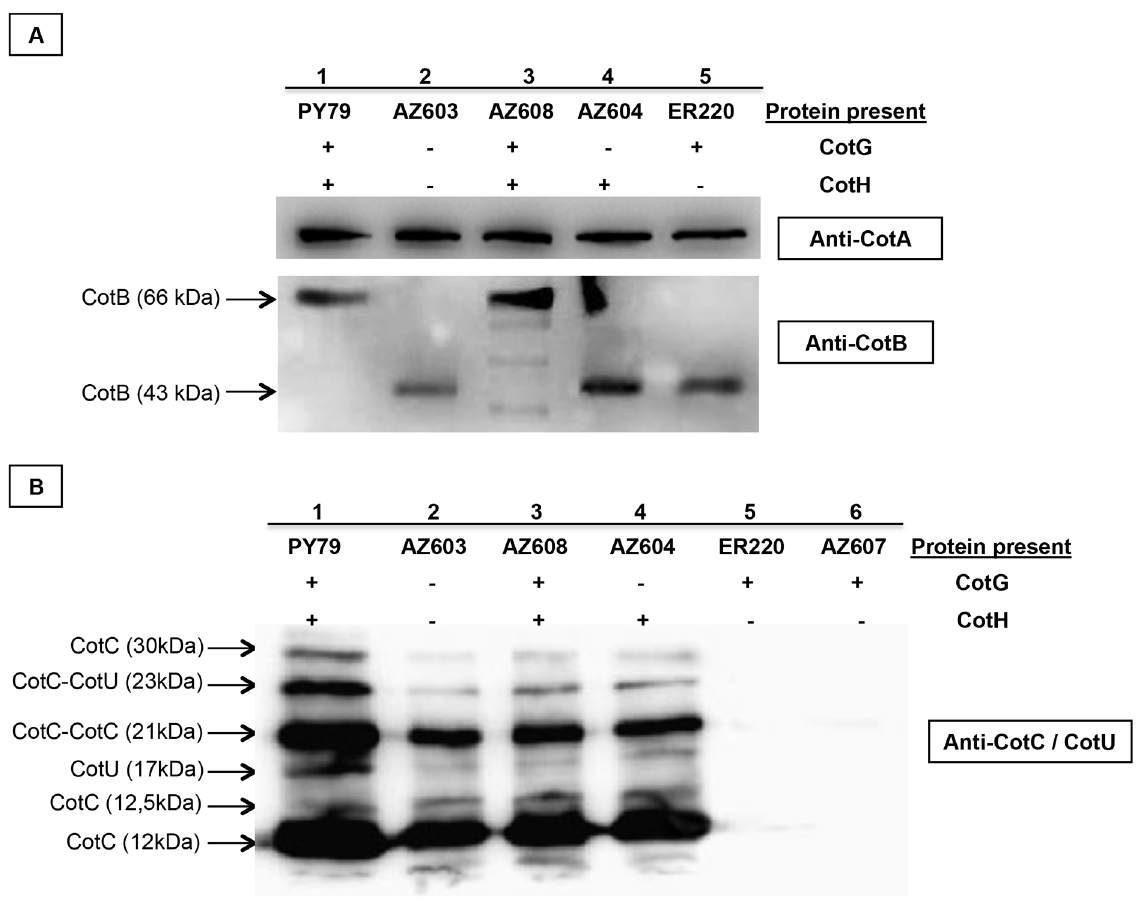
Figure 4. Western blot analysis. Western blot analysis of proteins extracted from mature spores of wild type (PY79, lane 1), D cotG D cotH (AZ603, lane 2), D cotG D cotH amyE::cotGcotH (AZ608, lane 3), D cotG D cotH amyE::cotG stop cotH (AZ604, lane 4), cotH::spc (ER220, lane 5) and D cotG D cotH amyE::cotG (AZ607, lane 6 of panel B) strains. For CotA and CotB detection (panel A) the proteins have been extracted by SDS treatment while for CotC and CotU detection (panel B) the NaOH treatment has been used. Proteins (25 m g) were reacted with CotA, CotB and CotC specific rabbit antibodies and then with peroxidase-conjugated secondary antibodies and visualized by the Pierce method. The estimated size of CotB, CotC and CotU is indicated.